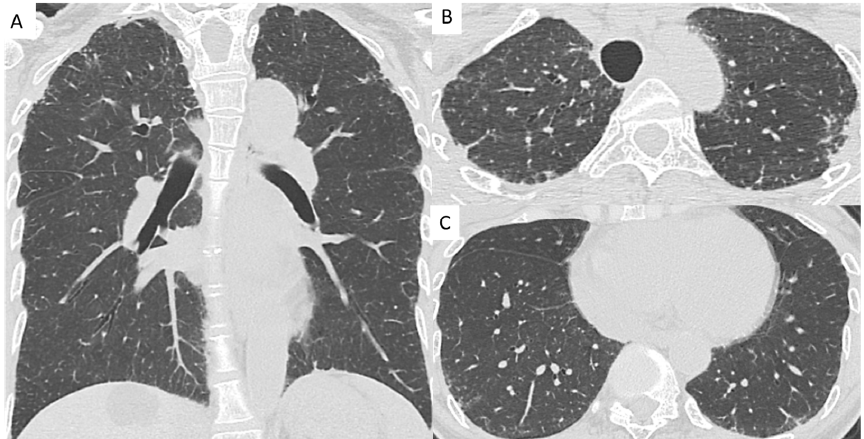
Figure 2. Chest computed tomography images from a patient with pleuroparenchymal fibroelastosis (PPFE) with hypersensitivity pneumonitis. ( A ) Chest computed tomography shows bilateral dense subpleural consolidation and a loss of upper lobe volume with hilar elevation in the coronal plane. ( B ) There are subpleural consolidation in the upper lobes. ( C ) Chest computed tomography shows ground-glass opacity and reticulation in the subpleural predominance of the lower lobes.